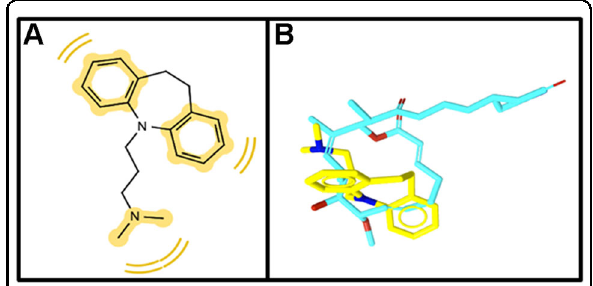
Fig. 1 Results obtained after ligand-based pharmacophore screening with LigandScout. a 2D diagram of matching hydrophobic pharmacophoric features between (yellow spheres) migrastatin and imipramine. b 3D alignment of migrastatin (blue skeleton) and imipramine (yellow